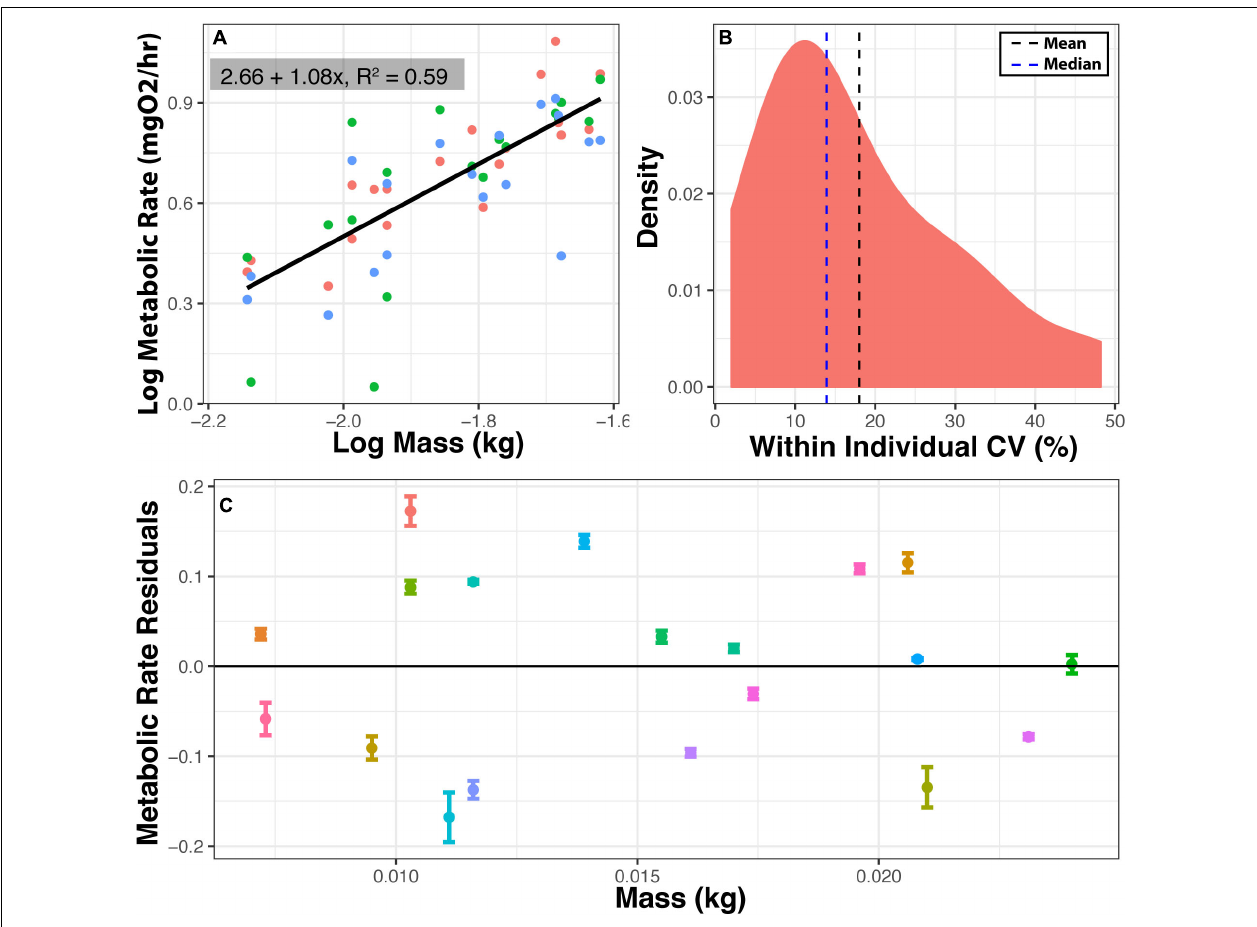
FIGURE 4 | Repeatability of metabolic measurements. Metabolic rate was measured three times for 19 individuals in three different chambers within 1 week. (A) Log metabolic rate (MgO 2 /h) vs. log body mass regression. Values are corrected for background respiration. (B) Distribution of coefficient of variation (CV) in minimum metabolic rate within an individual. CV = 100*(standard deviation/mean). (C) Mean and standard error for RMR residuals among 19 individuals. Means are residuals from log-log body mass regression. Thus, positive values indicate that an individual had a higher than expected metabolic rate based on mass, and negative values indicate that an individual had lower than expected metabolic rate based on mass. Ratio of variance between to variance within = 74.82:1. Repeatability =